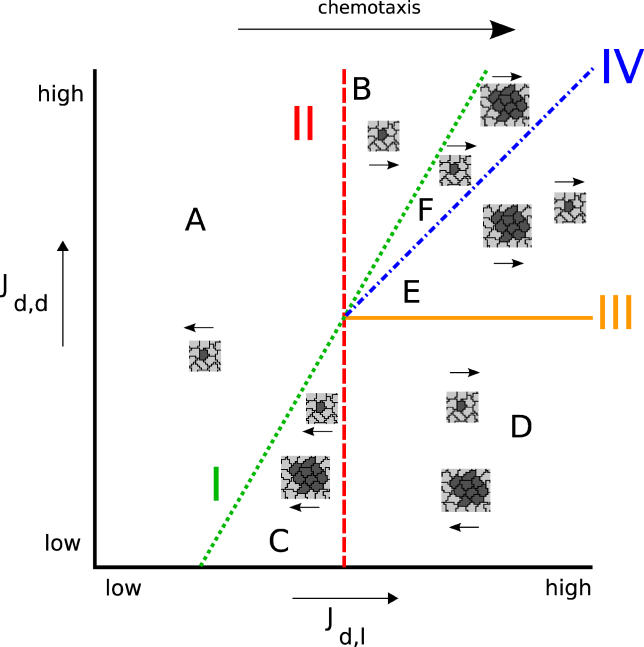
An Overview of Dependency of the Direction of Cell Sorting, for Both Single Cells and Small Clusters, on the Specific Combinations of Surface Energies, in a Confined Cell Mass
Jl,l is fixed; where the lines I–IV intersect, Jl,l = Jd,l = Jd,d. Line I corresponds to γ = 0 (Equation 6); line II to Jd,l = Jl,l; line III to Jd,d = Jl,l; and line IV to Jd,d = Jd,l. Arrows indicate the direction of sorting of the dark cell type, when chemotaxis directs cells to the right and movement is constrained. The arrows solely indicate the direction of sorting; quantitative differences between single cells and clusters are not shown. For movies of the cell behaviour in each region, see Videos S3–S8.